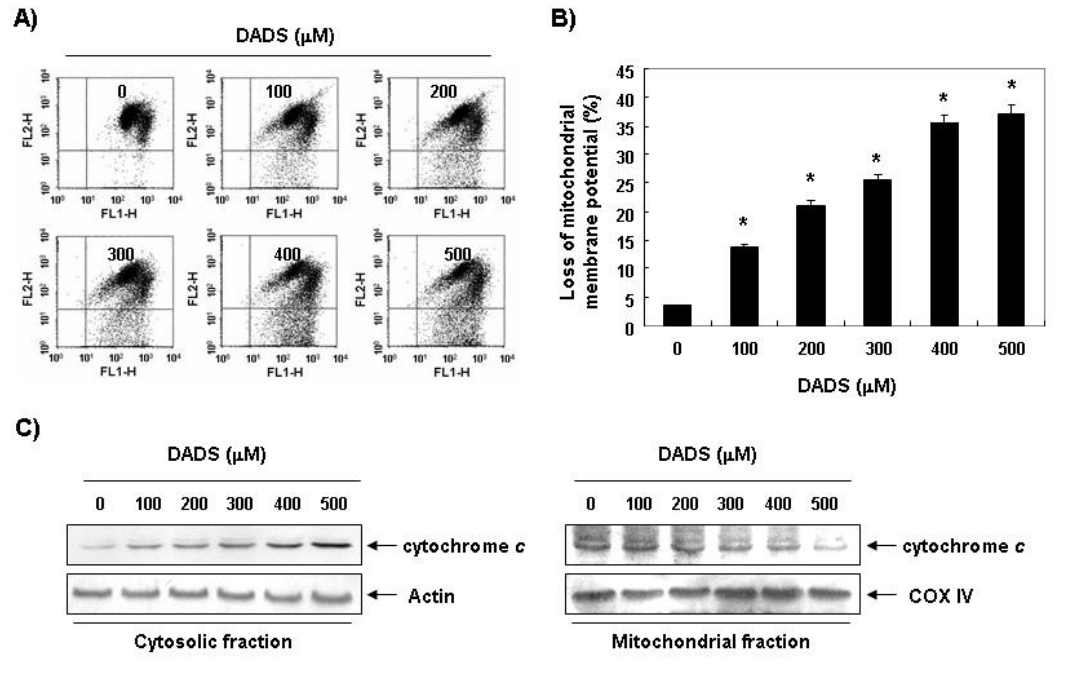
Figure 4. Effects of DADS on the levels of MMP in DU145 cells. ( A ) The cells were treated with the indicated concentrations of DADS for 48 h. They were collected and incubated with JC-1 (10 μ M) for 20 min at 37 °C in the dark. The cells were then washed once with PBS and analyzed by a DNA flow cytometer; ( B ) The results are presented as the mean ± SD of three independent experiments. The significance was determined by the Student's t -test ( * p < 0.05 vs. untreated control); ( C ) The cytosolic and mitochondrial proteins were extracted cells grown under the same conditions and analyzed by Western blotting using the indicated antibodies. Actin and COX4 were used as internal controls for the cytosolic and mitochondrial fractions,